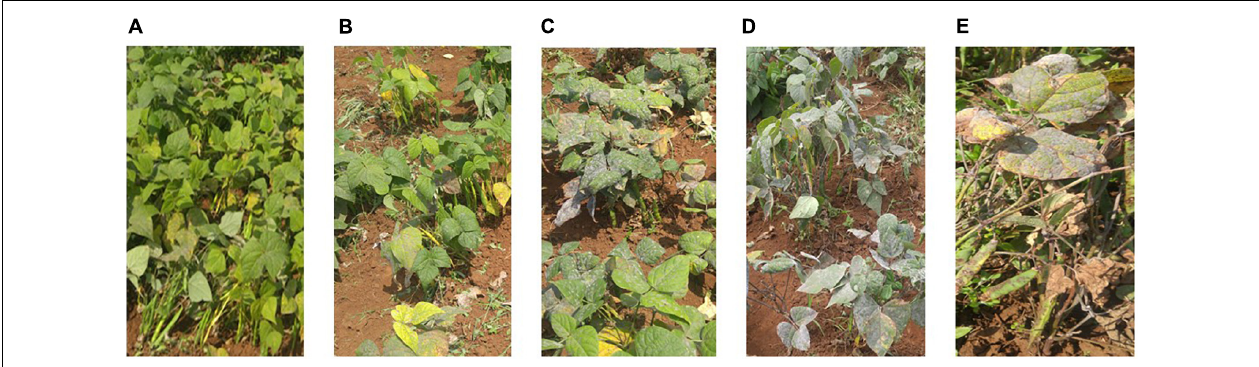
FIGURE 1 | Different disease severity scores evaluated in the field condition. Photos (A–E) showed phenotypes with different scales 1, 3, 5, 7, and 9 of the disease severity, respectively.